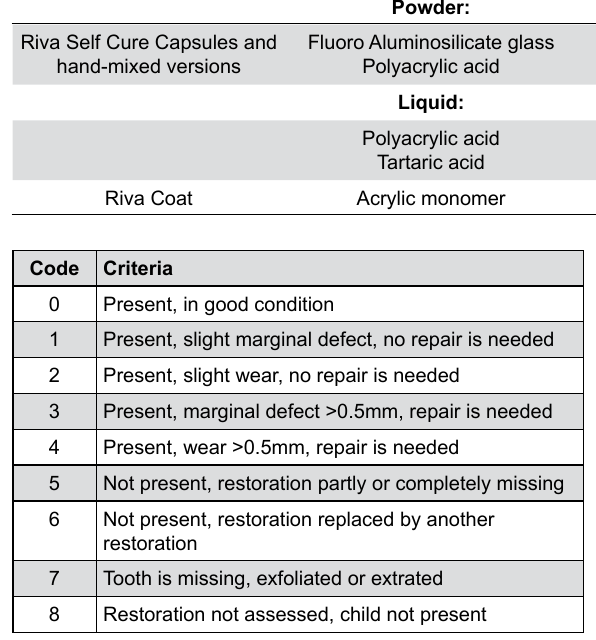
Figure 2- ART criteria according to Lo and Holmgren 12